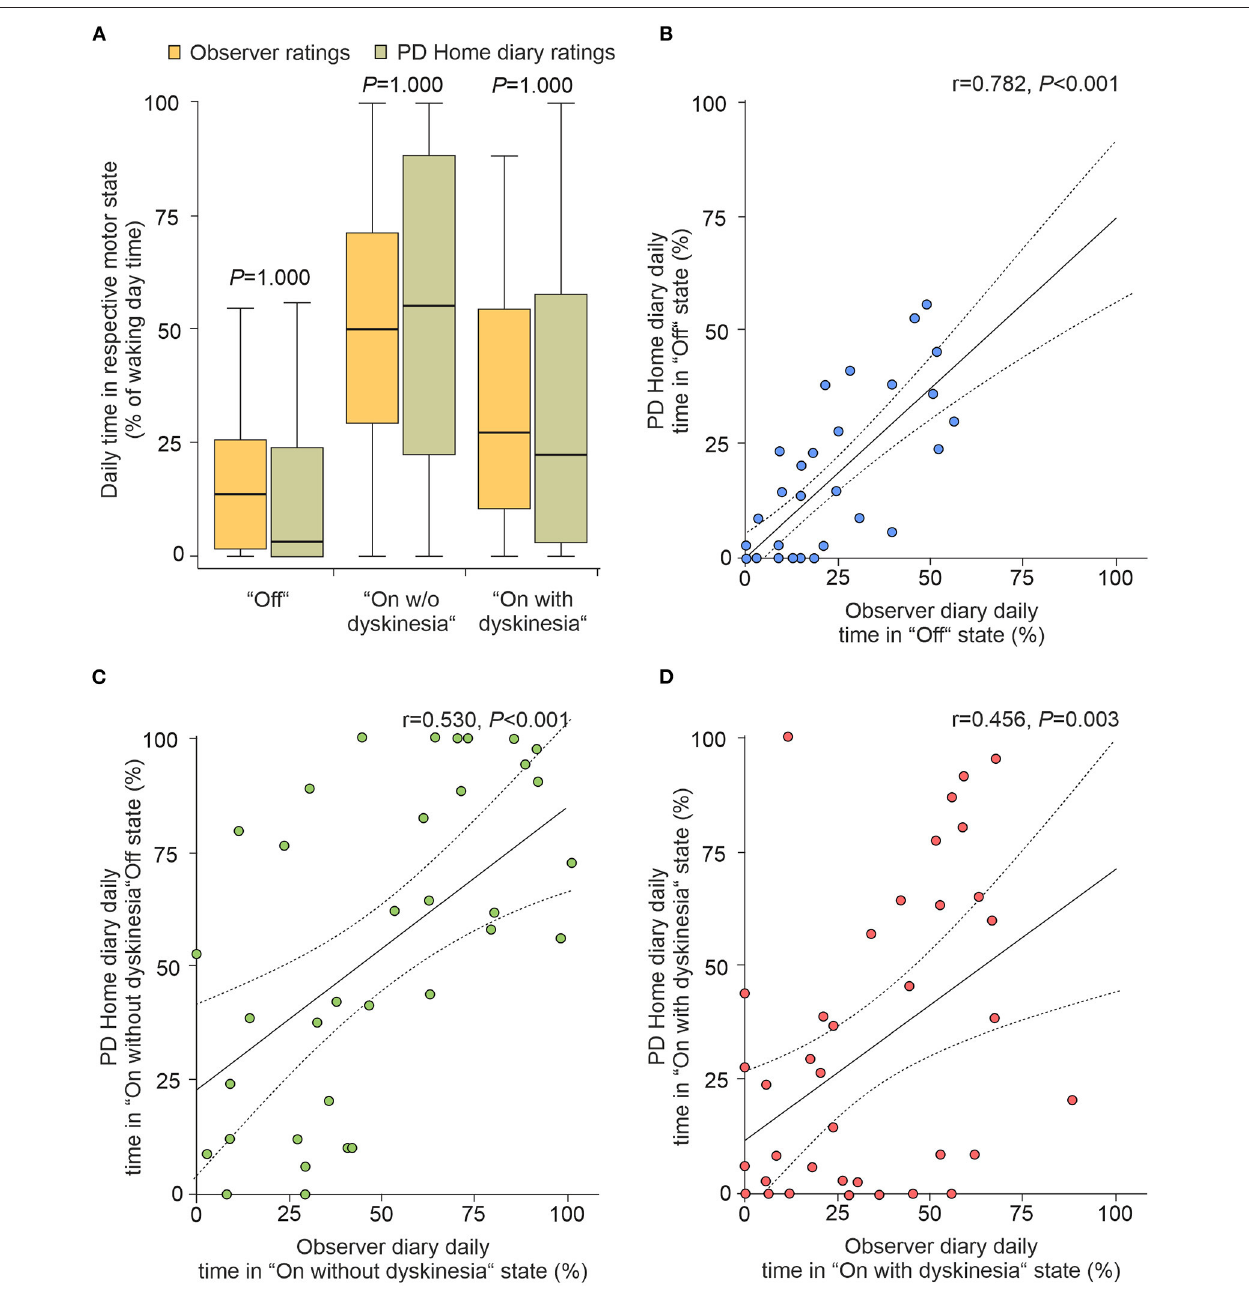
FIGURE 2 | Proportions for time spent in motor states assessed by observer diaries and PD Home diaries on participant level. (A) Distribution of daily time proportions of “Off”, “On without dyskinesia” and “On with dyskinesia” based on the simultaneous, half-hourly performed diary ratings from 40 participants from two consecutive days (8 am to 4 pm). Boxplots are shown with a central mark at the median, bottom, and top edges of the boxes at 25th and 75th percentiles, respectively, whiskers out to the most extreme points within 1.5 times the interquartile range. Displayed P -values are from Friedmann tests with post-hoc Wilcoxon signed-rank tests with Bonferroni correction for multiple comparisons. (B–D) Correlation analyses of mean proportions of “Off” (B) , “On without dyskinesia” (C) and “On with dyskinesia” (D) . Solid lines in represent the regression line with 95% CI (dotted lines). Values in upper right corner are the correlation coefficients and P- values from Pearson’s correlation tests. PD, Parkinson’s disease; CI, confidence